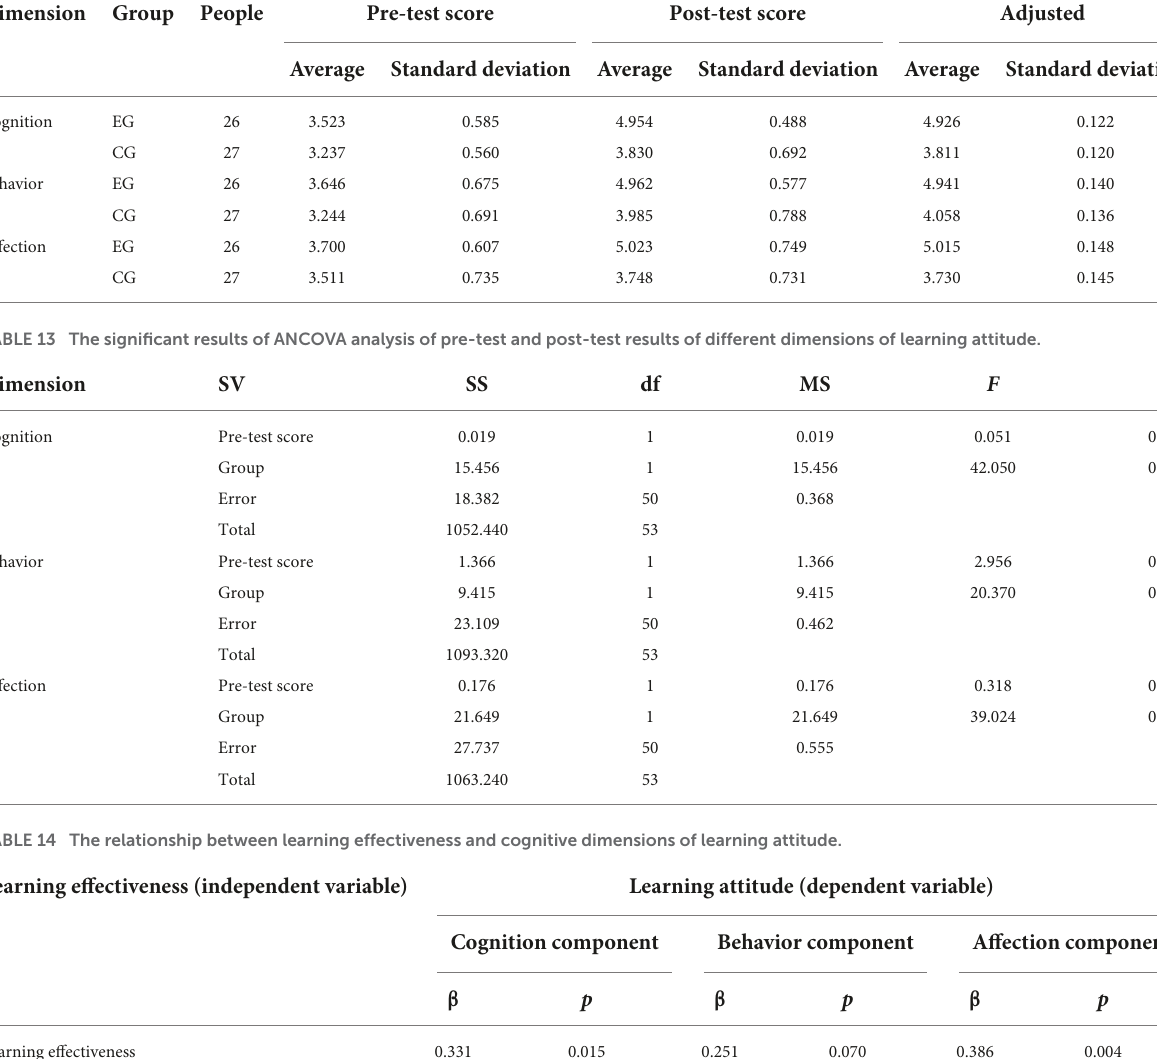
TABLE 12 The ANCOVA analysis of pre-test and post-test results of different dimensions of learning attitude. Dimension